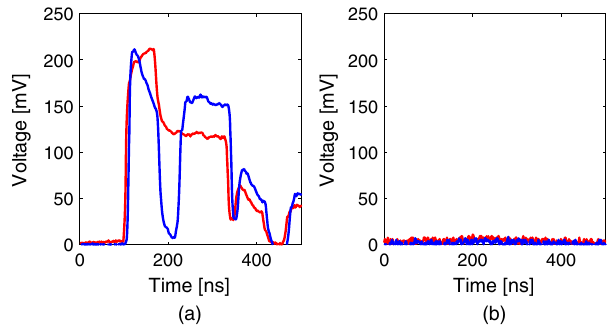
FIG. 14. Pulse waveform of breakdown event without current flash at flat top pulse width of 250 ns. (a) Directional coupler signals. The red curve is the incident microwave signal and the blue curve is the reflected microwave signal. (b) Faraday cup signals. The red curve is the signal of the power feed end and the blue curve is the signal of the power cut